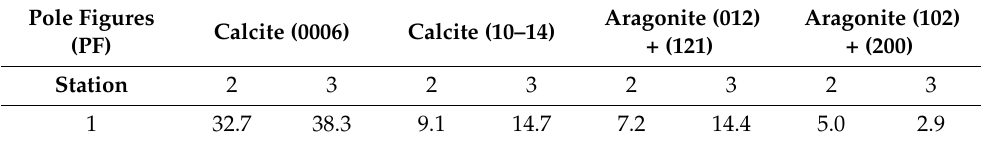
Table 6. RP (%) values for calcite and aragonite pole figures for the samples of M. galloprovincialis shells. Pole